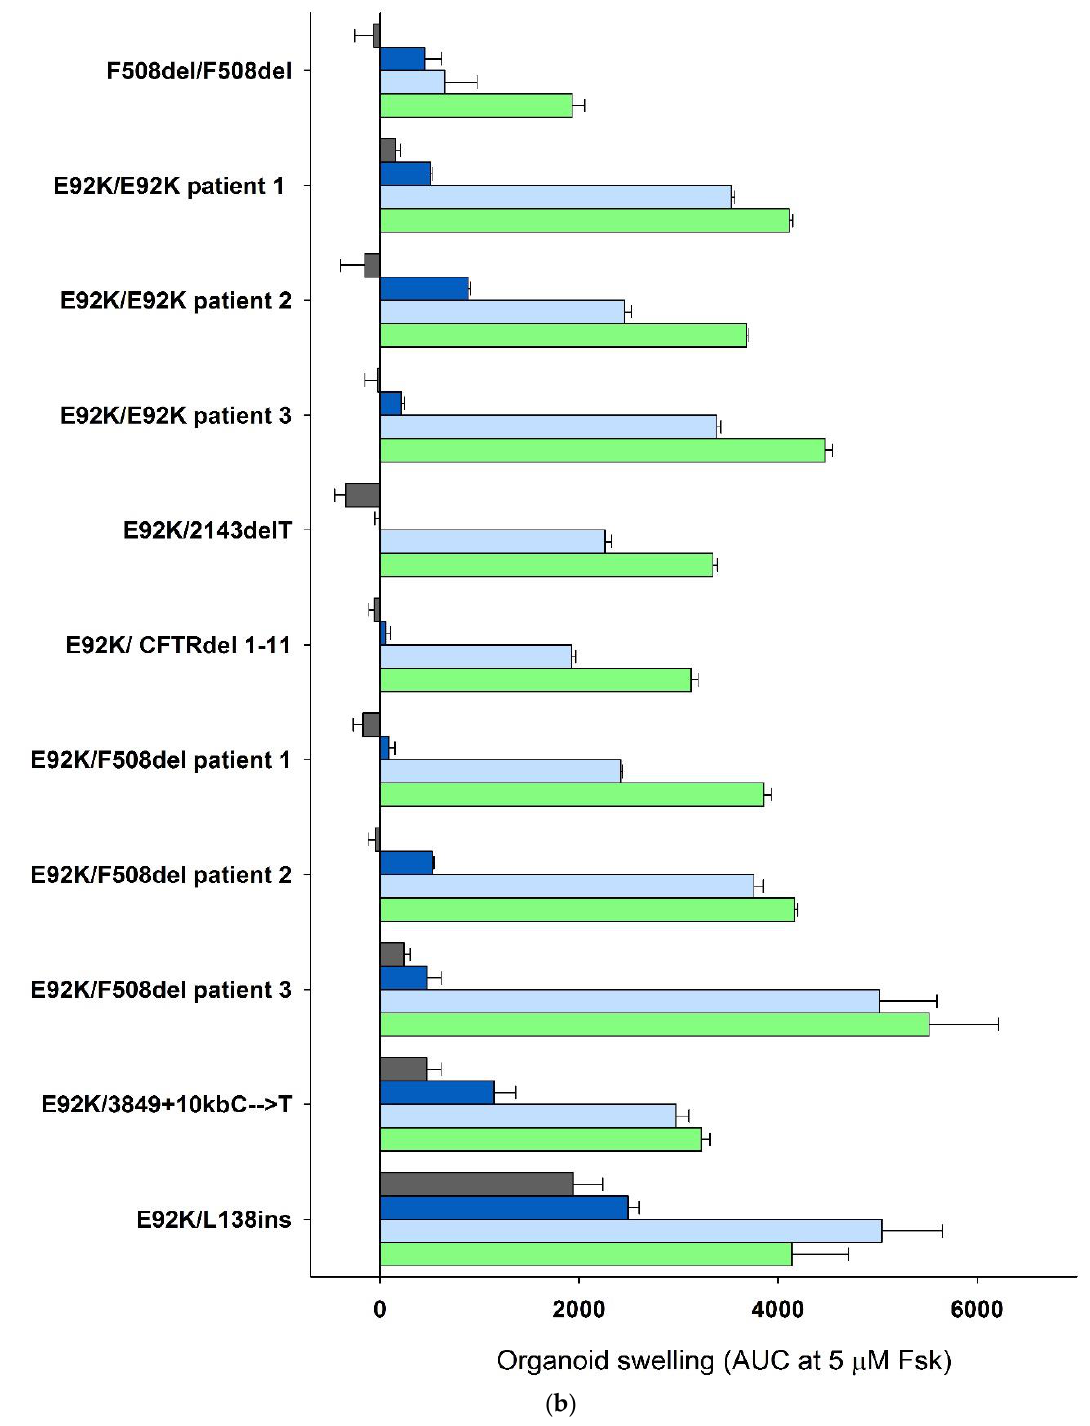
Figure 5. Results of quantitative assessment of organoid swelling under the action of forskolin and CFTR modulators for homo-/heterozygotes with the E92K-CFTR variant in comparison with F508del/F508del control. Concentrations—0.128 µM Fsk ( a ) and 5 µM Fsk ( b ); 3.5 µM VX-770 and 3.5 VX-809.